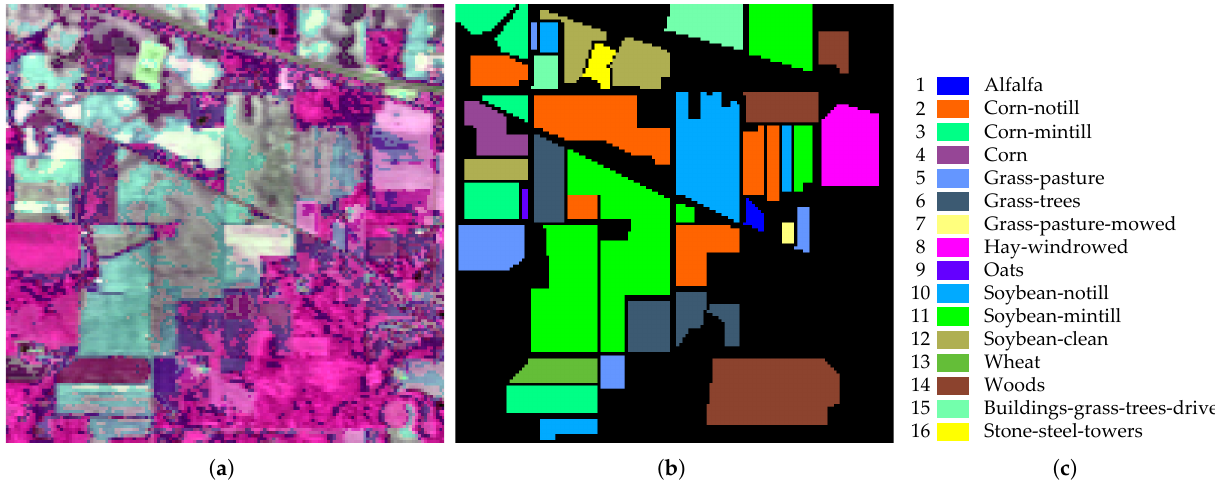
Figure 6. The Indian Pines Dataset. ( a ) The false-color image. ( b ) The ground-truth map. ( c ) The corresponding color labels. Pavia University (UP): It was gathered by the Reflective Optices Spectrographic Imaging System (ROSIS) over the Pavia University in Italy, 2001. It is comprised of 103 effective bands with spectral range from 0.43 to 0.86 µ m after removing 12 noisy bands. The image of UP has 610 × 340 pixels with spatial resolution of 1.3 mpp, and 9 feature image and the corresponding color labels are revealed in Figure